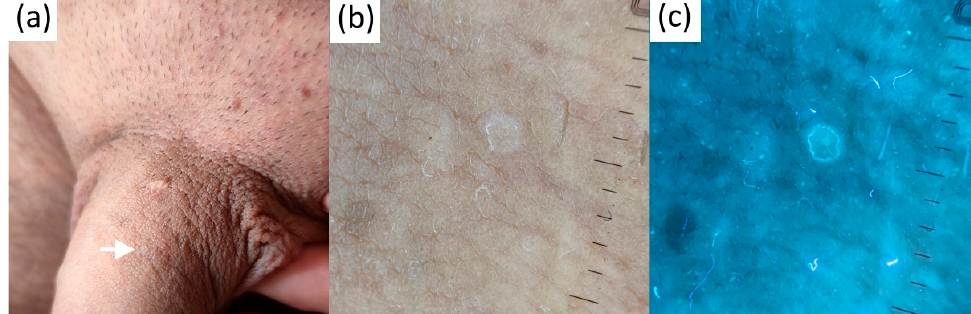
Figure 7. Clinical ( a ), contact-polarized ( b ), and ultraviolet-induced fluorescence ( c ) dermatoscopic images of genital porokeratosis.